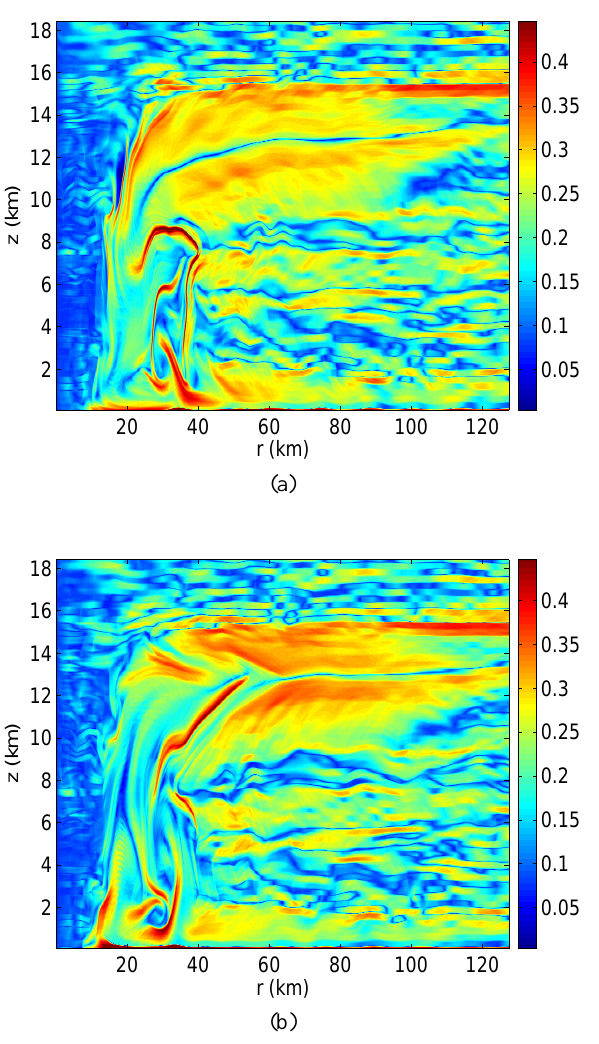
Fig. 6. Forward (a) and backward (b) time FTLE fields integrated 20 minutes with an initial time of 420 minutes.